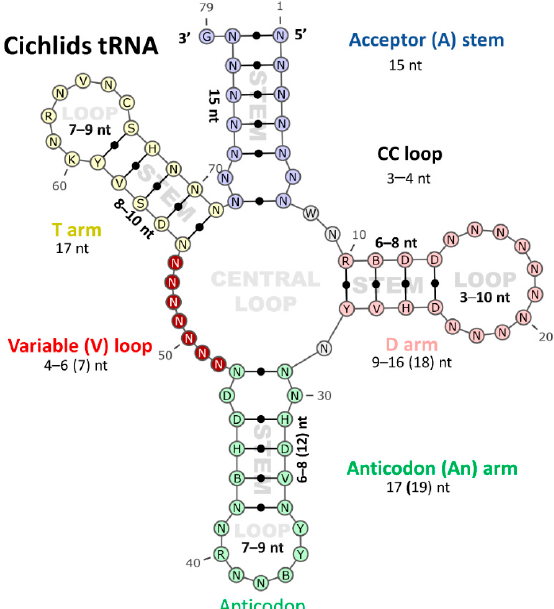
Figure 2. The tRNA secondary structures model represents the consensus sequence of 21 tRNAs in cichlid species. Each stem-loop is shown with a specific color. Arms of tRNAs (clockwise from top) are the amino acid acceptor stem (light purple), the dihydrouridine arm (light red), the anticodon arm (green), variable loop (dark red), and the thymidine arm (light yellow). The secondary structure model includes the standard tRNA numbering. The minimum and maximum length of each domain (stem and loop) are shown, and the numbers between brackets represent length with gaps. Degenerated nucleotides are used.